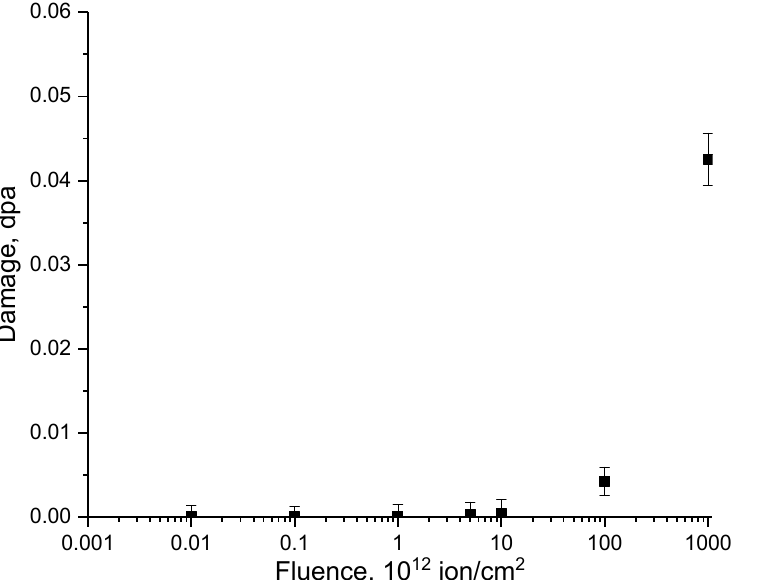
Figure 3. Dependence of the change in the value of atomic displacements depending on the irradiation fl uence.